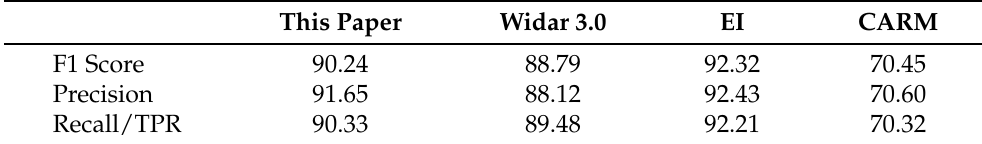
Table 1. Comparison of recognition accuracy of all models in WiAR.